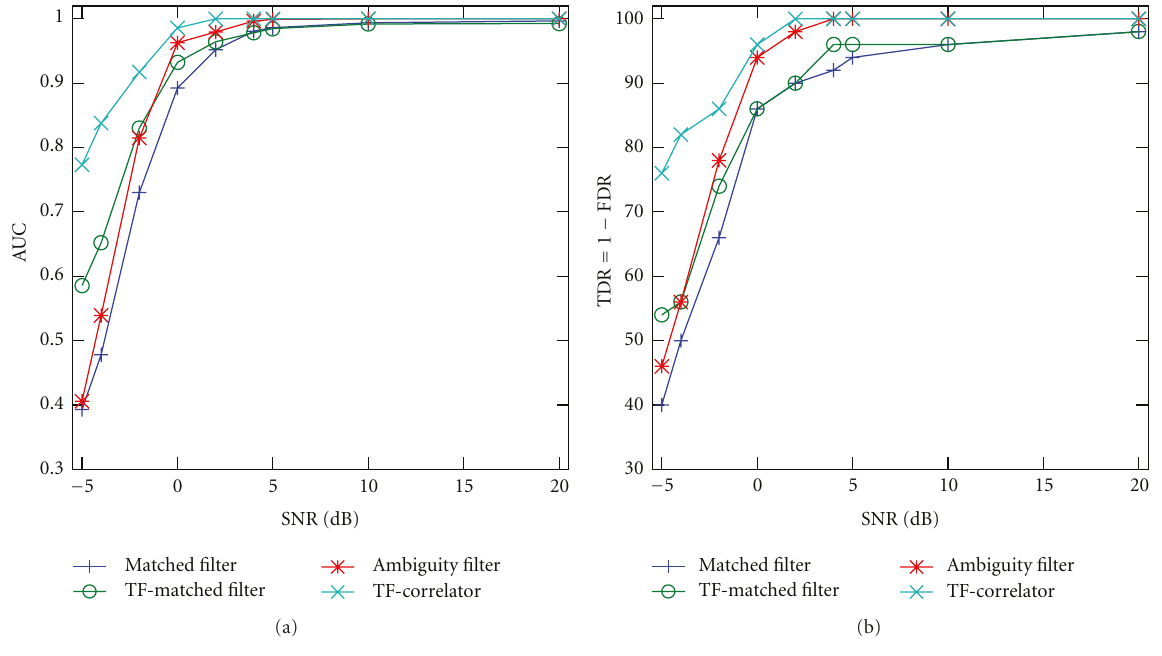
Figure 7: Results for detecting signals in coloured Gaussian noise with low-energy harmonics.